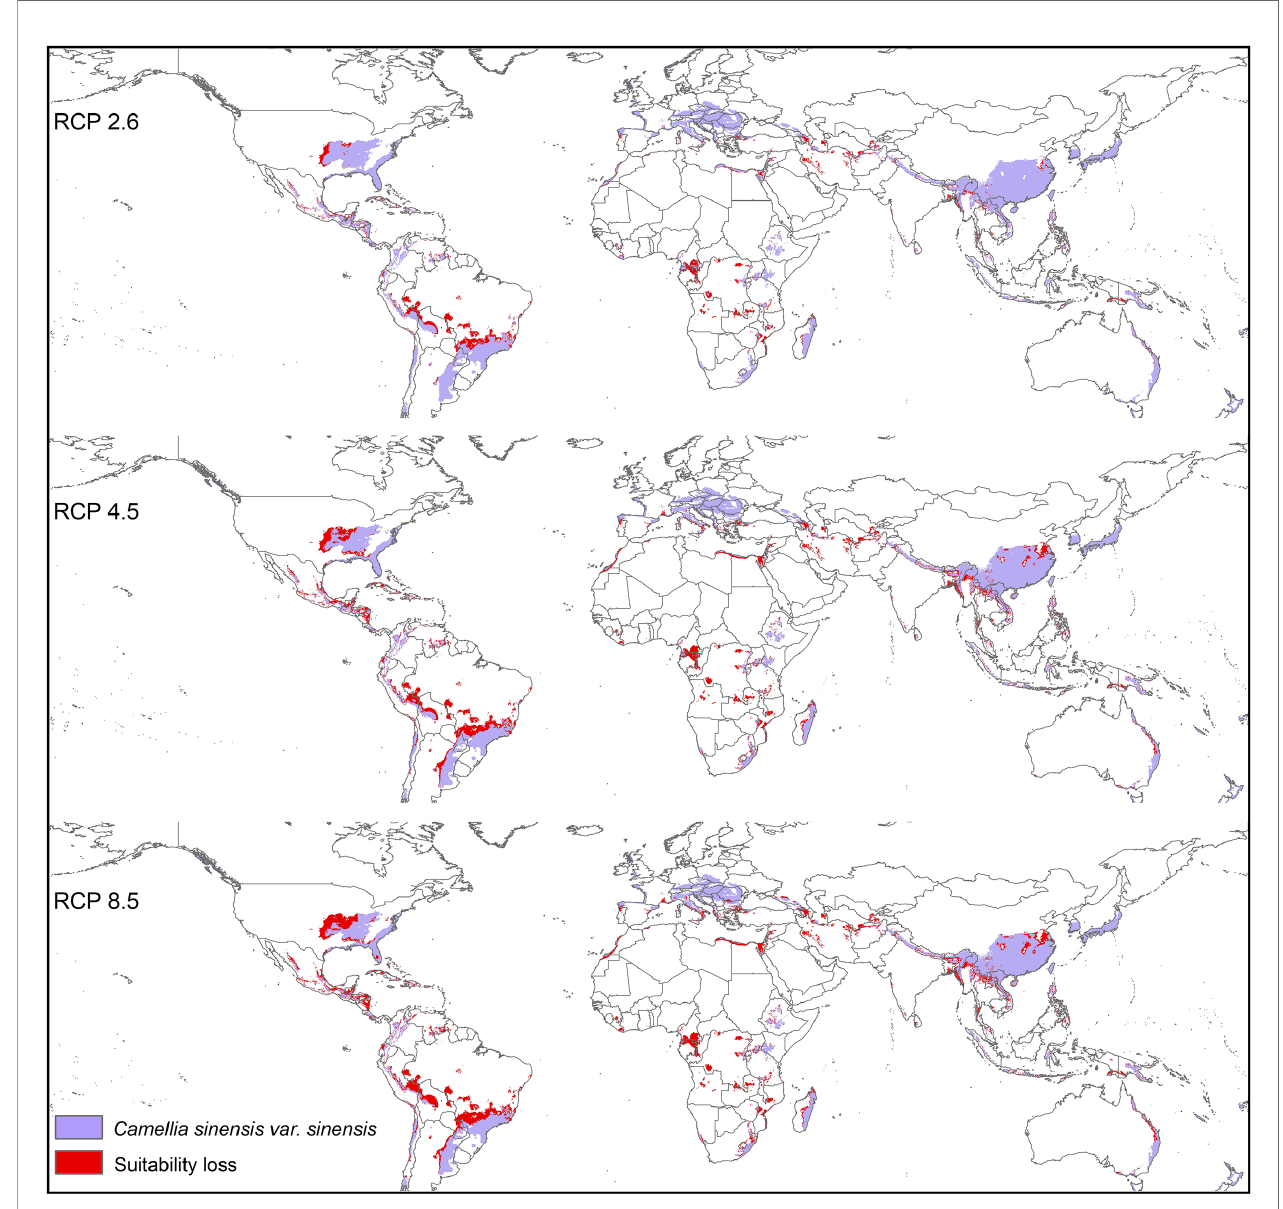
FIGURE 2 | Suitable areas for C. sinensis var. sinensis growing under future climate scenarios with baseline suitable areas and losses by 2050 (purple represents the suitable areas, and red represents lost suitable